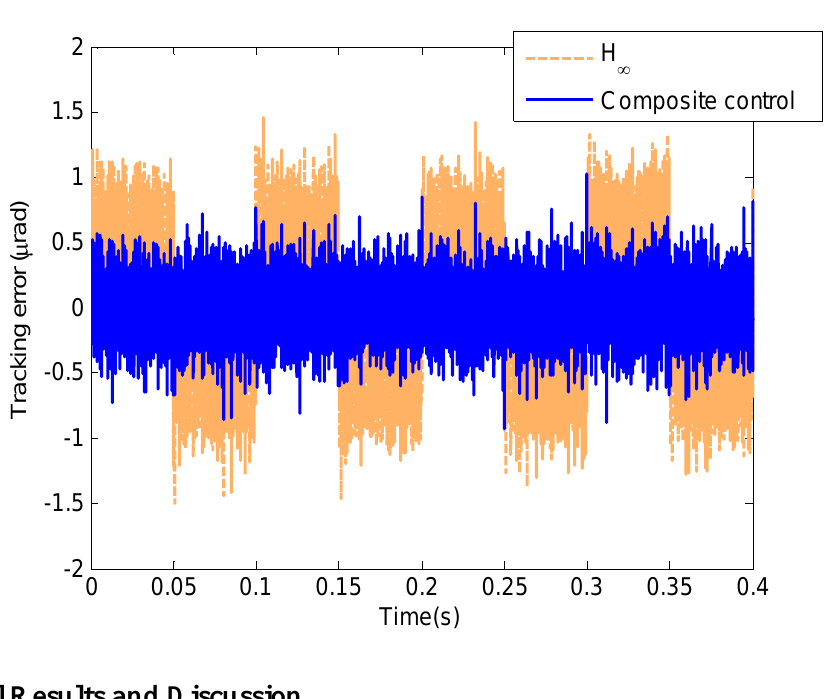
Figure 12. Tracking errors in simulation study.